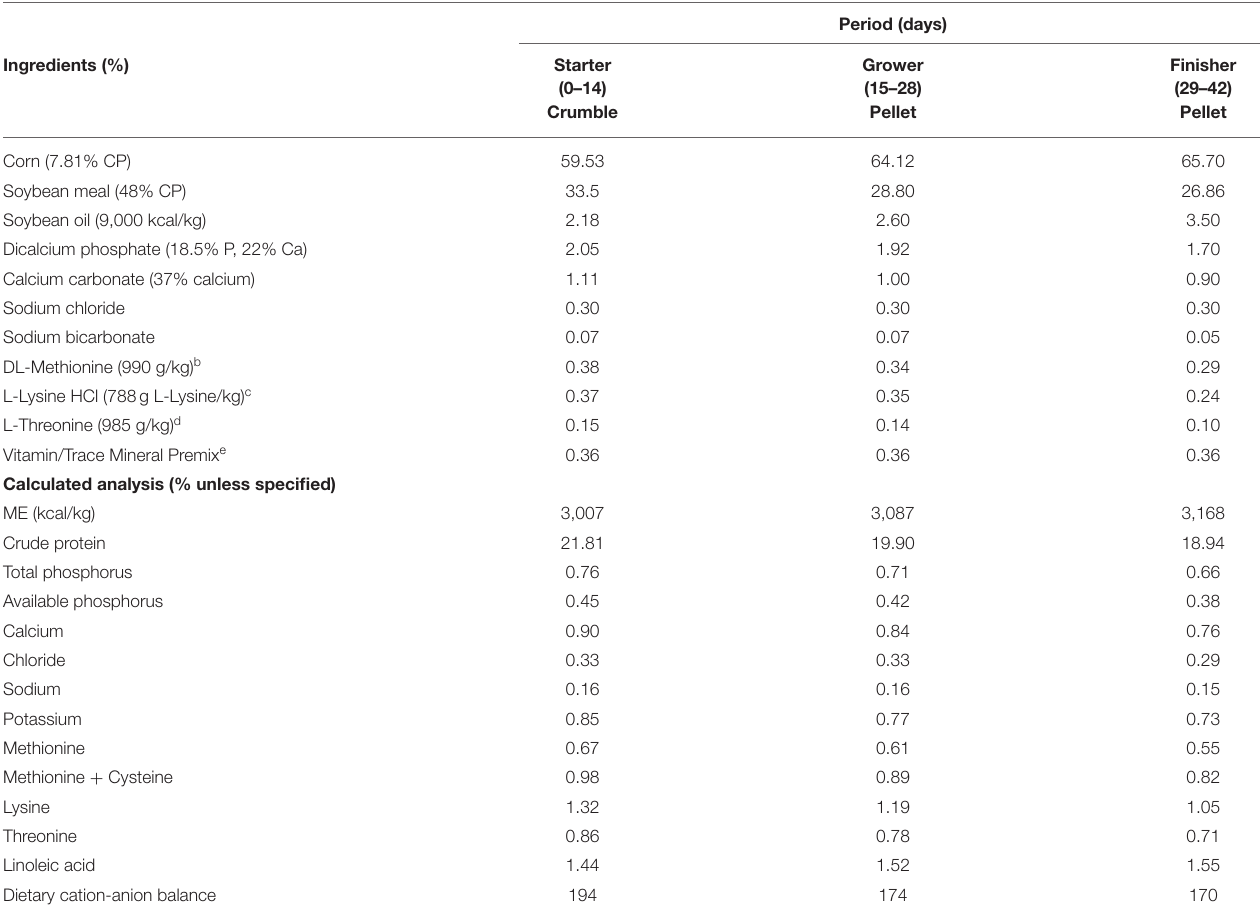
TABLE 1 | Composition of basal diets (as fed basis, %) a